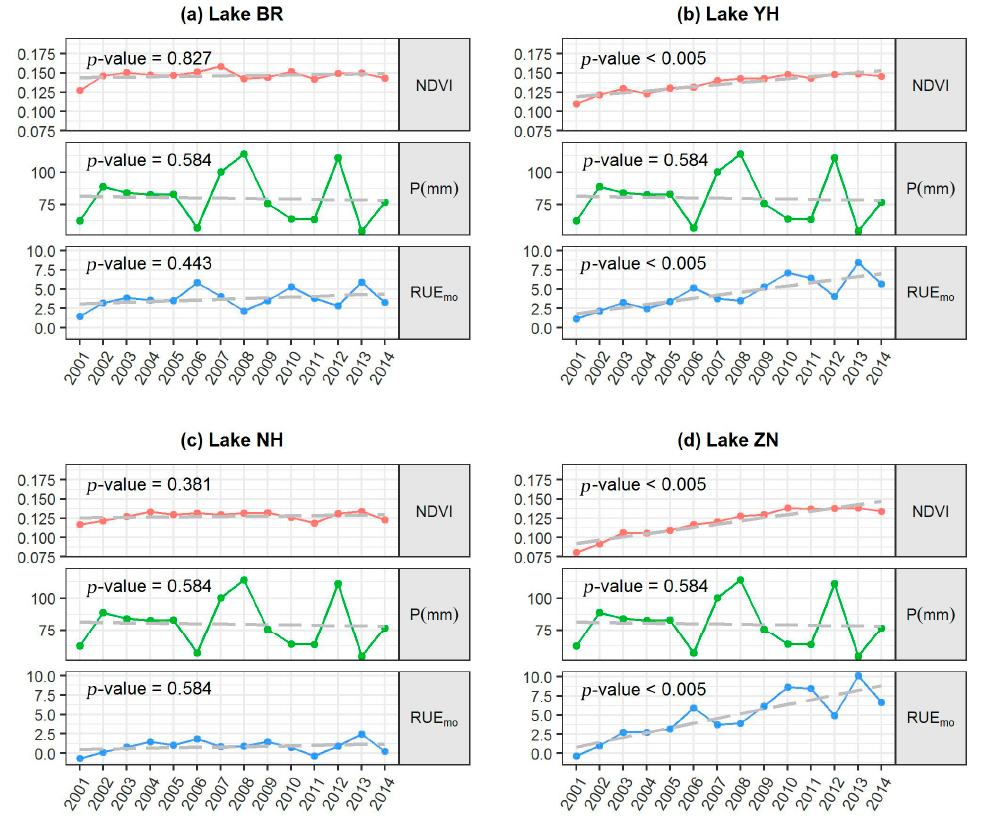
Figure 9. Annual average values of NDVI (red lines), precipitation (green lines), and the RUE mo (blue lines) from 2001 to 2014 over the four selected lake basins of ( a ) Lake BR; ( b ) Lake YH; ( c ) Lake NH; and ( d ) Lake ZN.